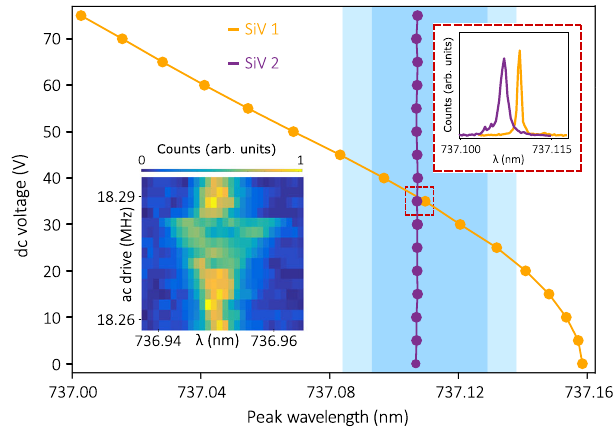
FIG. 1. Schematic of diamond nanophotonics device. (a) Dia- mond waveguides (gray) are implanted with color centers (purple and orange) at desired locations on the device. Electrodes (gold) are used to define a capacitor between plates located on the device (negative terminal) and below the device (positive terminal). Applying bias voltage between the plates causes the deflection of the doubly clamped cantilever. This tunes color centers between the plates and the first clamp (orange circle) without perturbing color centers beyond the clamp (purple circle). (b) Scanning electron micrograph (SEM) of the photonic devices. (c) Capacitor plates located on and below the devices. (d) Diamond tapers used to extract photons from waveguides. This enables the extraction efficiency of more than 85% from the diamond waveguide into the fiber.